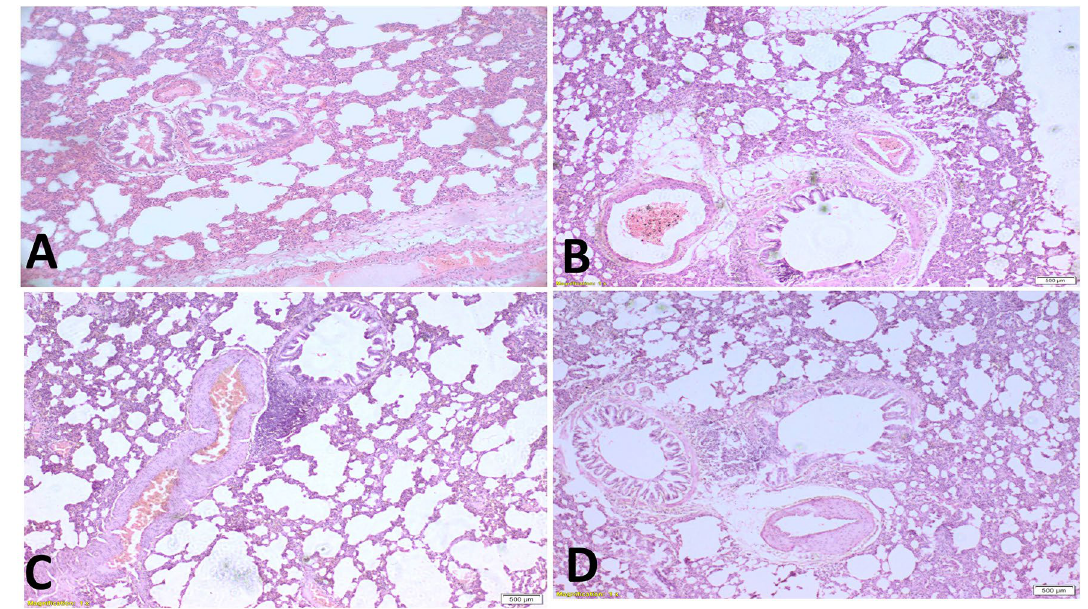
Figure 8. Histological evaluation of male Sprague–Dawley rats lung tissues stained with Haematoxylin and Eosin (H&E). Untreated lung tissues ( A ), lung tissues treated with Nile Tilapia fish scale-based collagen nanoparticles ( B ), lung tissues treated with theophylline ( C ), lung tissues treated with Nile Tilapia fish scale- based collagen nanoparticles loaded with theophylline ( D